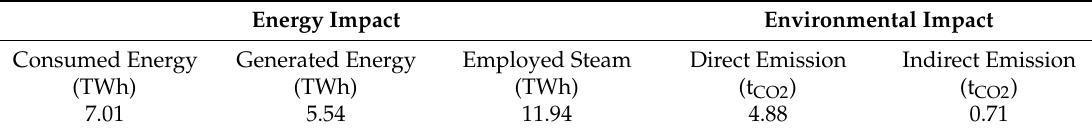
Table 1. Energy and environmental impact of the Italian paper